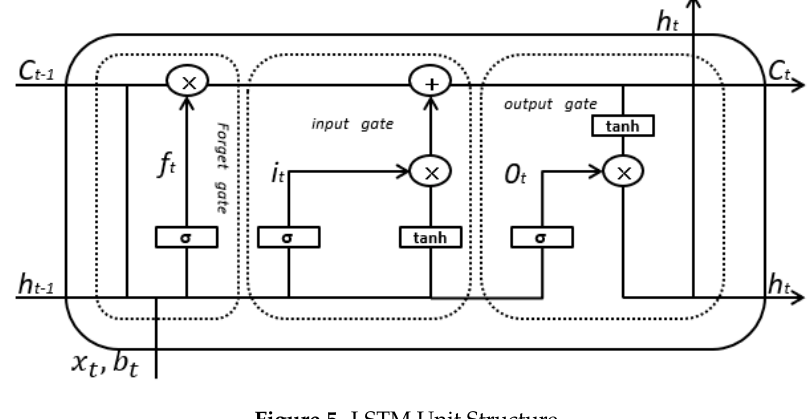
Figure 5. LSTM Unit Structure.